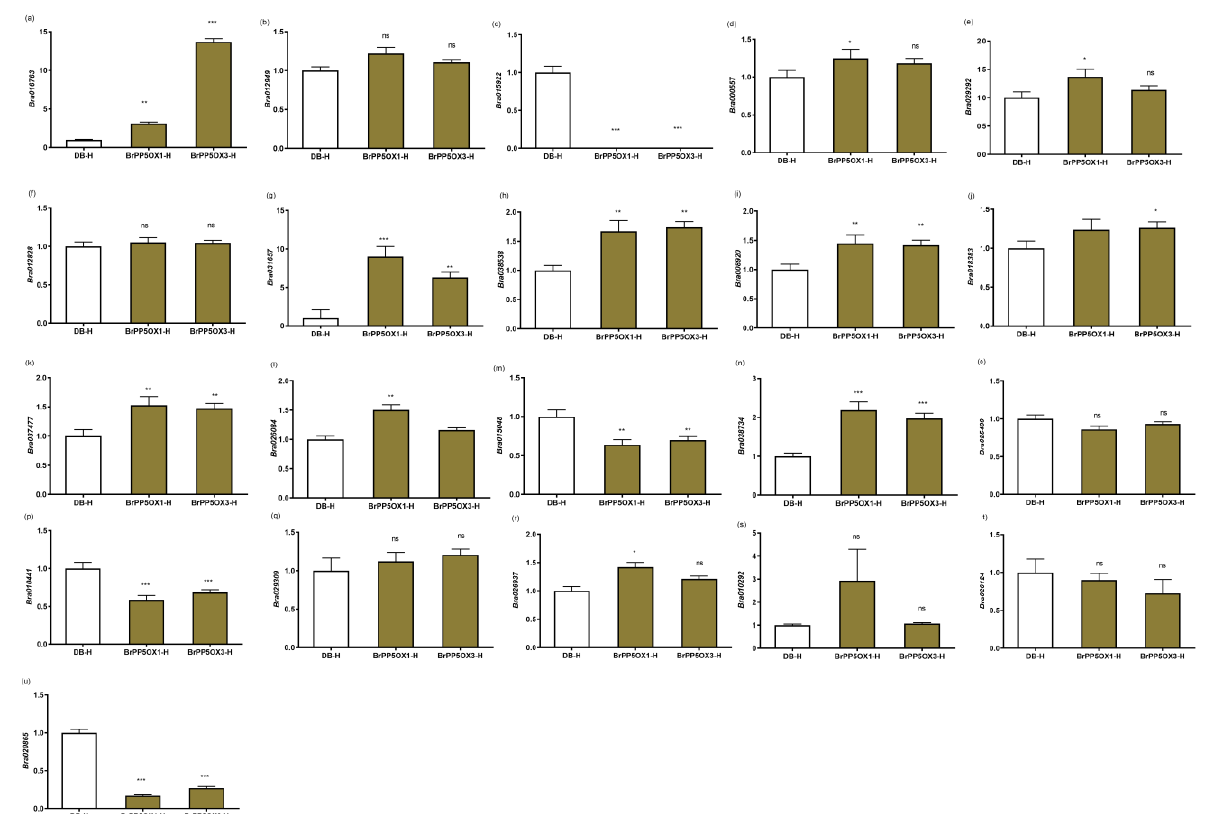
Figure 5. Expression profiling of temperature stimulus response genes under heat stress in transgenic and control lines. ( a – u ) The column charts represent the relative expression pattern of DDF1 (Bra016763) ( a ), HSP17.4-CIII (Bra012949) ( b ), ATHSP101 (Bra015922) ( c ), ATHSFA2 (Bra000557) ( d ), AT-HSFB2A (Bra029292) ( e ), AT-HSFA7A (Bra012828) ( f ), BIP3 (Bra031657) ( g ), MIPS2 (Bra038538) ( h ), HSP17.6II (Bra008920) ( i ), HSP17.6B-CI (Bra018383) ( j ), ROF2 (Bra037477) ( k ), Hsp70b (Bra026084) ( l ), MBF1C (Bra015048) ( m ), HSP70 (Bra038734) ( n ), TCH2 (Bra025439) ( o ), ABI1 (Bra010441) ( p ), Tudor domain-containing protein , AT5G61780 (Bra029309) ( q ), CYP71B2 (Bra026937) ( r ), TCH4 (Bra010292) ( s ), DR12 (Bra026124) ( t ), and HSP26.5-P (Bra020865) ( u ) measured by quantitative RT-PCR assay in cDNA libraries derived from 2-month-old transgenic and control lines ( n = 3 or more) exposed to 37 ◦ C for 1 h. Each column represents the normalized gene expression values derived from qRT-PCR replicates, while error bars denote the standard deviations. One-way ANOVA (Dunnett’s multiple comparisons) test was performed in GraphPad Prism 8.0.2 to determine the significant variation from controls grown under optimal growth conditions. Ns = non-significant; * = p < 0.05; ** = p < 0.01; *** = p < 0.001. BrACT2 was used for gene expression normalization.